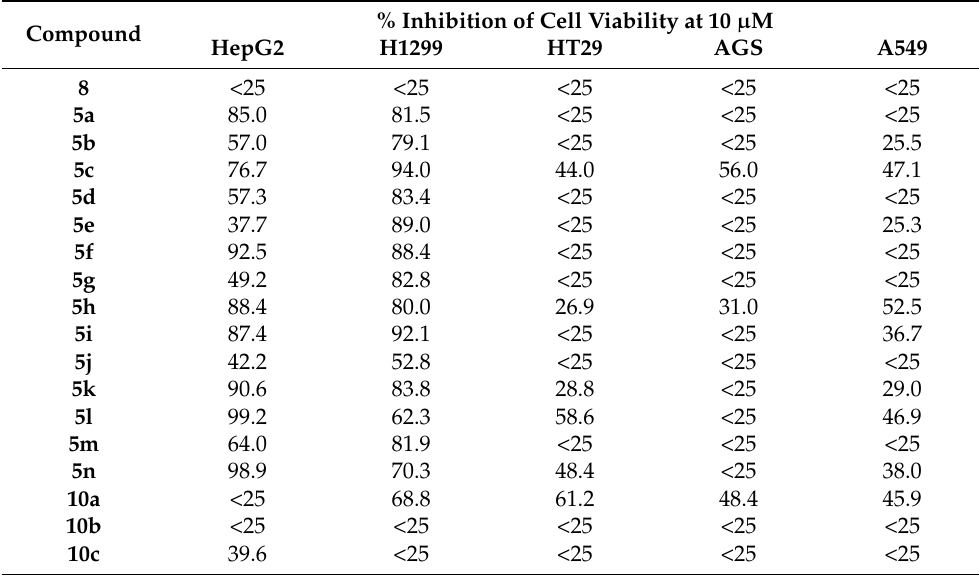
Table 2. Cytotoxicity of 5 , 8 , and 10 in HepG2, H1299, HT29, AGS and A549 cells (mean, n = 3).